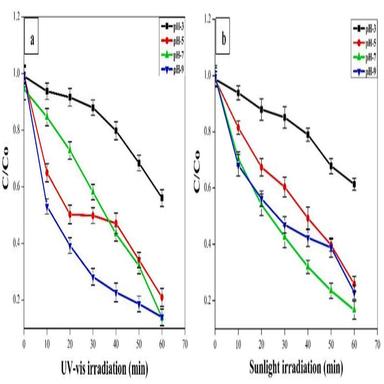
Effect of pH in (a) UV–vis irradiation (b) Sunlight irradiation.